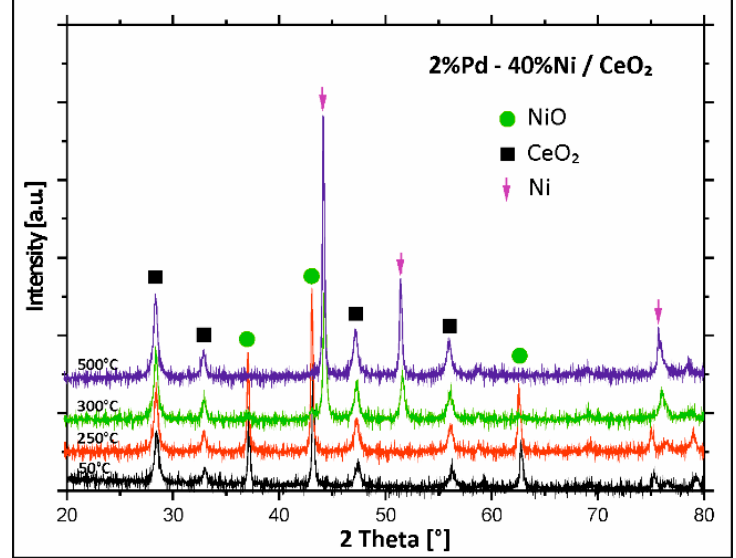
Figure 4. X-ray powder patterns recorded during reduction of calcined bimetallic Pd–Ni/CeO 2 in a mixture of 5%H 2 –95%Ar in the temperature range 50–500 ◦ C.